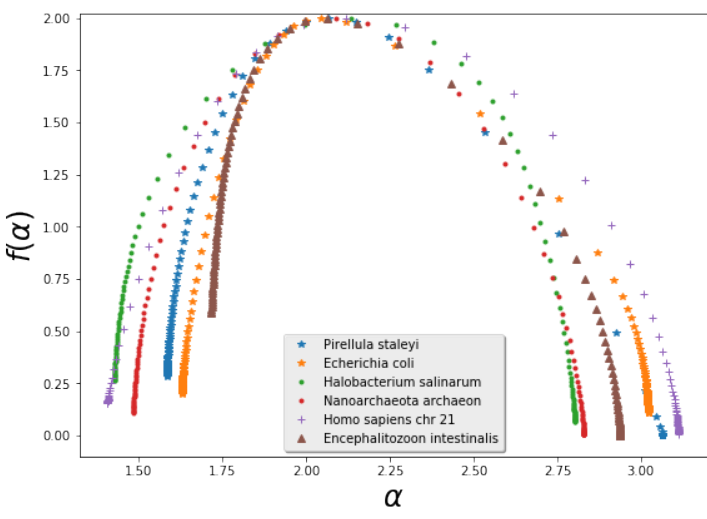
Fig. 6 Multifractal spectra of two bacterias: Pirellula staleyi and Escherichia coli, two archaea: Nanoarchaeota archaeon and Halobacterium salinarum , the Homo sapiens chromosome 21 and a fungi Encephalitozoon